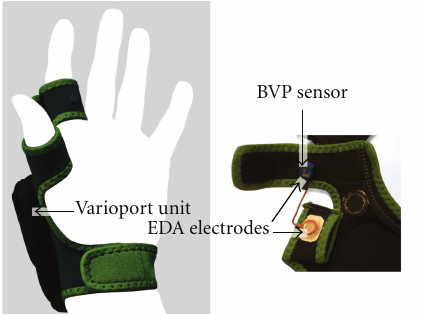
Figure 9: Sensor glove for measuring skin conductance wirelessly.